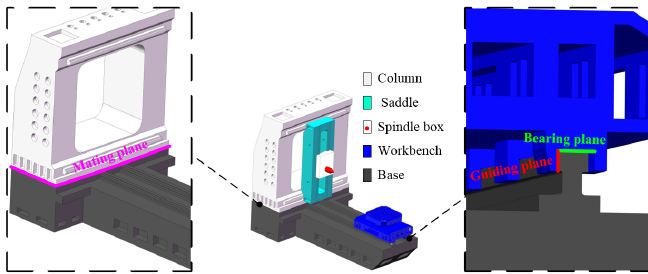
Figure 1. Assembly cases of single and multiple planes.